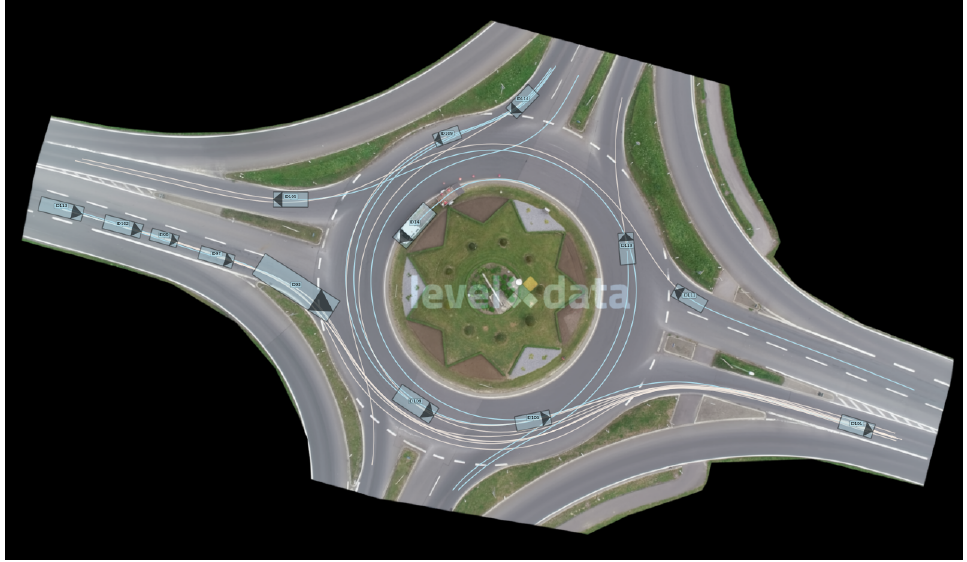
Figure 1. Recording at Neuweiler